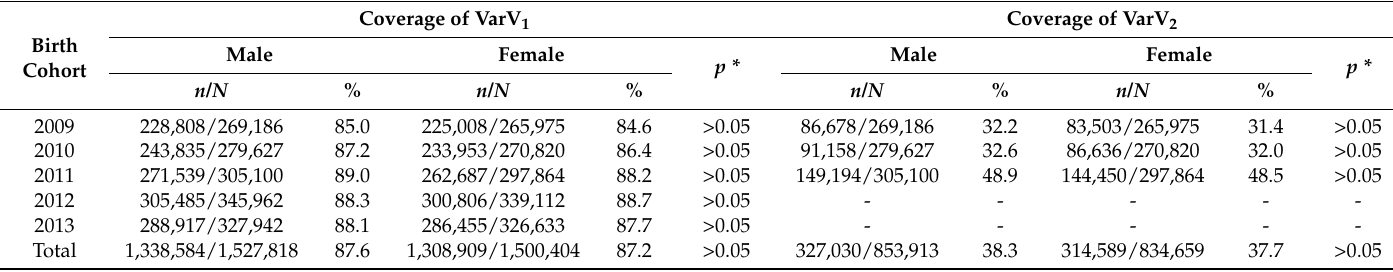
Table 3. Vaccination coverage of VarV for children born from 2009 to 2013 in Zhejiang province, by gender.